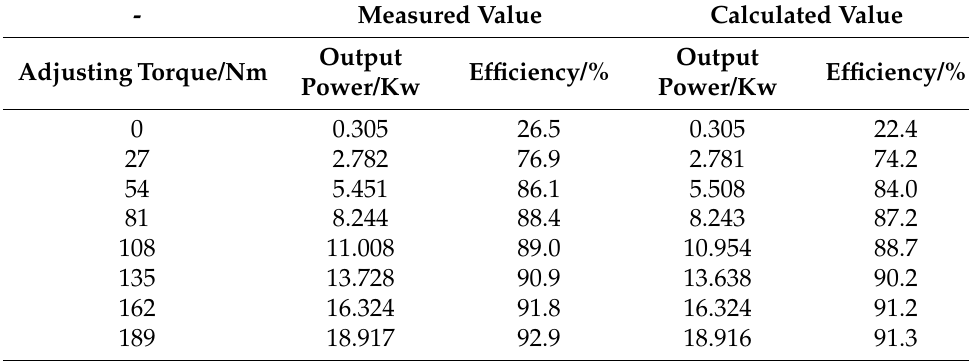
Table 15. Load power and